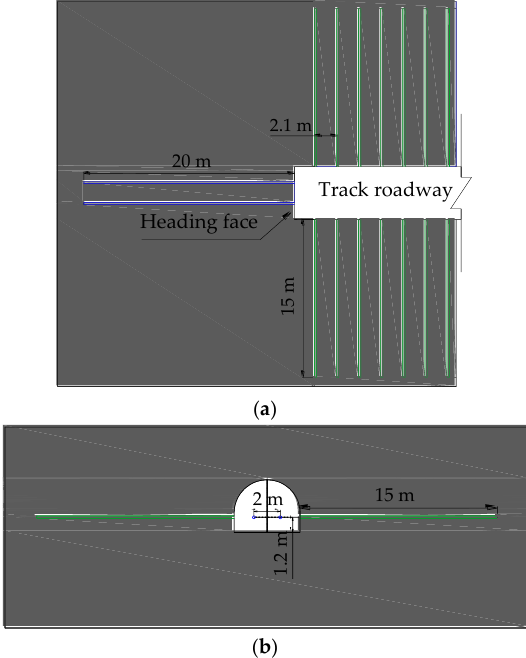
Figure 17. Large-diameter destress boreholes at the heading face and roadway sidewalls in the top slice of coal seam: ( a ) Planar graph; ( b ) Profile along the roadway tendency.